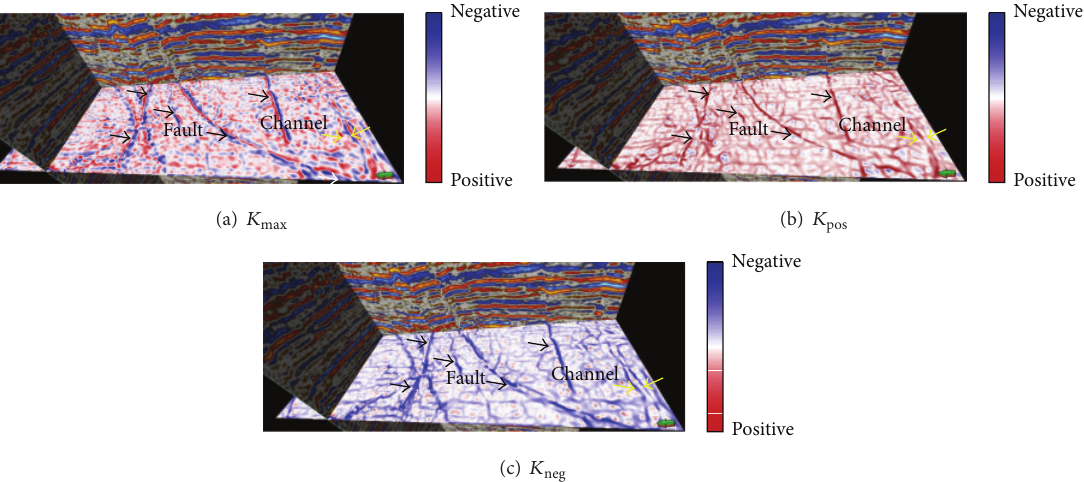
) , and (c) most-negative curvature (𝐾 pos